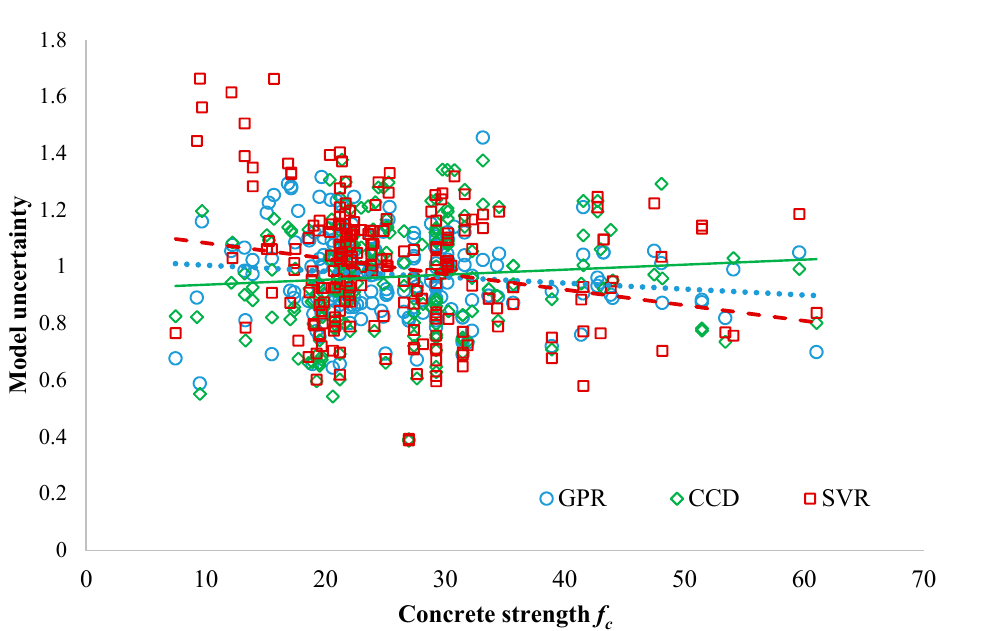
Figure 10. Scatter plots of Model uncertainty versus breakout parameters for all the models. Table 5. Trend analysis of the model uncertainty.